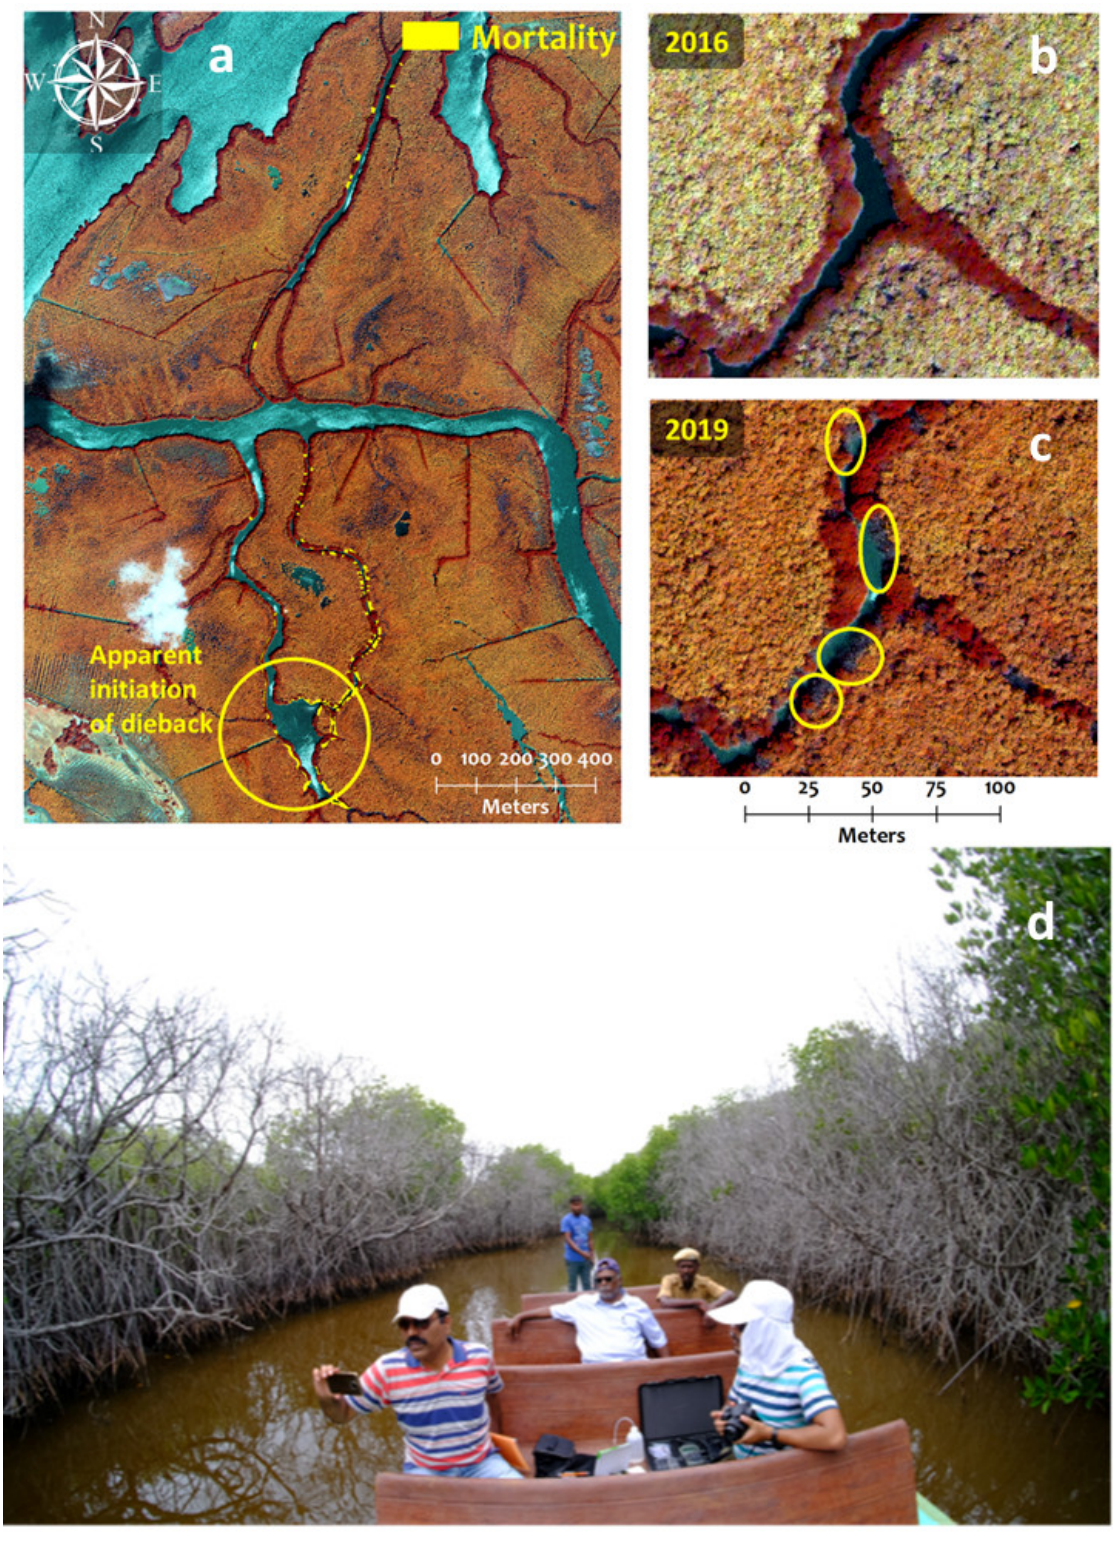
Figure 10. Rhizophora dieback spots in Pichavaram highlighted from the 2019 Worldview-3 image ( a ). Inset images show areas with presence of Rhizophora in 2016 ( b ) and subsequently dieback in 2019 ( c ), as confirmed by in situ observations ( d ).